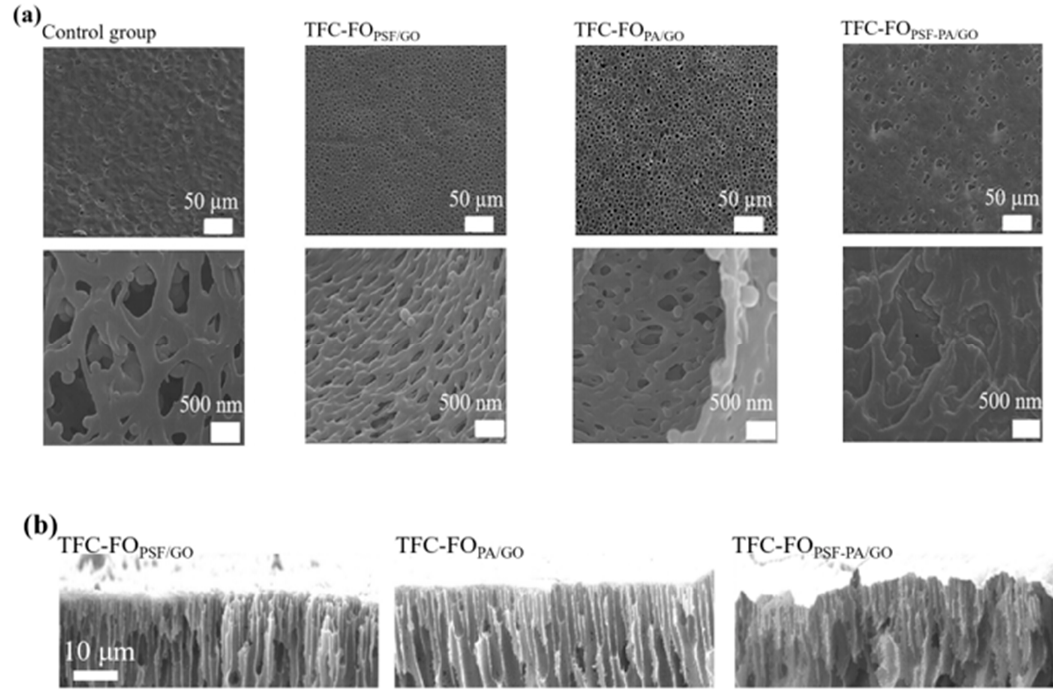
Figure 1. SEM images of FO membranes. ( a ) surface and ( b ) cross section. As shown in Figure 1a, a porous structure was formed on the membrane surface after GO doping, reducing the ICP and facilitating water molecule transport. The diameters of the pores in the control group were 500~1000 nm; these in TFC-FO PSF/GO , TFC-FO PA/GO and TFC-FO PSF-PA/GO were 100~400 nm, 300~500 nm, and 700~2000 nm. With the enlarge- ment of the membrane pores, we could see that the membrane pores were intertwined with numerous dense reticular channels. This unique “network structure” provided high water flux and good salt interception performance of the membranes. For TFC-FO PSF/GO and TFC-FO PA/GO , the membrane water channels were dense and uniform after GO doping because the MPD-GO crosslinked body was crosslinked with TMC as well when the mem- brane contacted with TMC. However, the membrane water channels formed by doping GO in the two layers simultaneously were not fully developed, and the porosity was lower than that of TFC-FO PSF/GO and TFC-FO PA/GO . During the IP processes for the